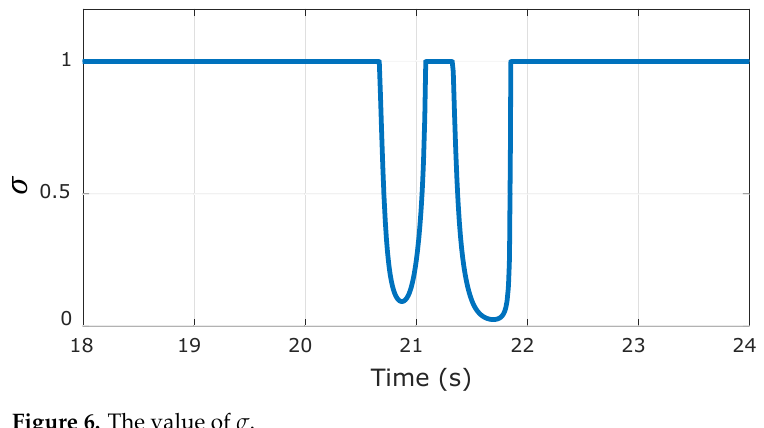
Figure 6. The value of σ